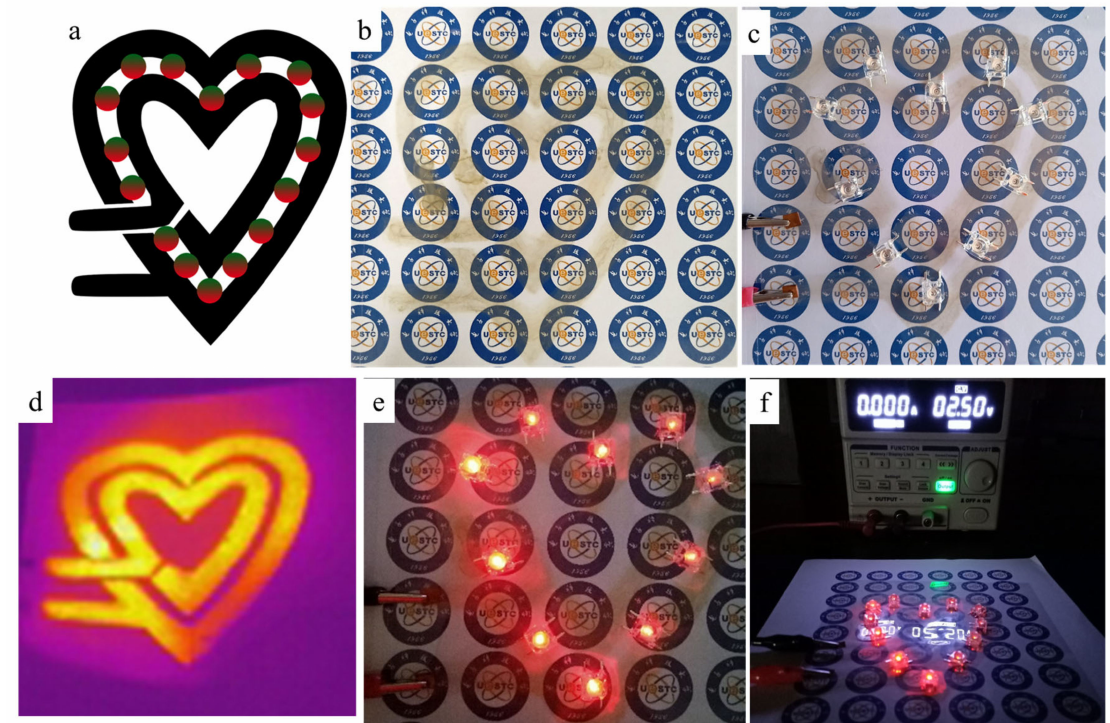
Figure 13. Designed pattern with a circuit (black) and LED beads (circles) ( a ), photographs of printed pattern before ( b ) and after ( c ) heat treatment, infrared thermal imaging ( d ), lighting on the LED beads ( e ), and applied direct current (DC) voltage of 2.5 V ( f